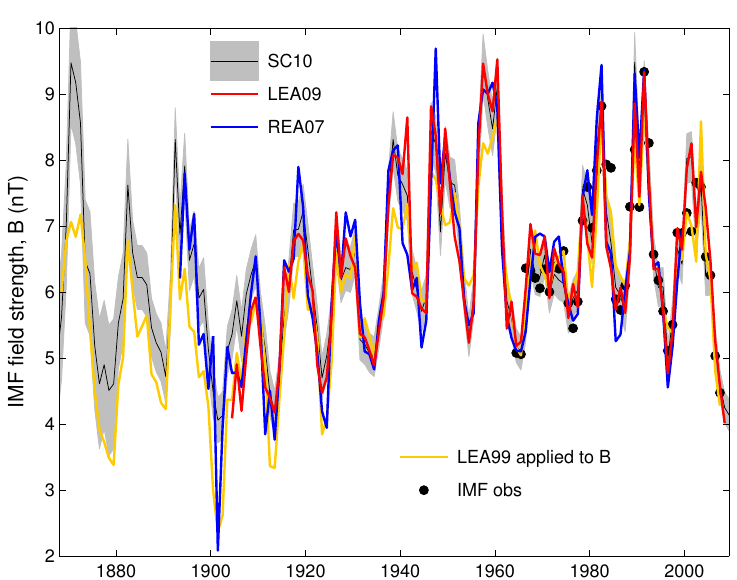
Figure 26: Reconstructions of annual means of the near-Earth IMF field strength 𝐵 from geomagnetic activity data: LEA99 (orange) uses the method of Lockwood et al. (1999a) applied to 𝑎𝑎 𝐶 ; LEA09 (red) is by Lockwood et al. (2009d) and uses 𝑎𝑎 𝐶 and 𝑚 ; REA07 (blue) is by Rouillard et al. (2007) and also uses 𝑎𝑎 𝐶 and 𝑚 ; SC10 (thin black line with uncertainty shown by the surrounding grey area) is by Svalgaard and Cliver (2010) and uses 𝐼𝐷𝑉 . Solid circles show annual means of IMF observations from the OMNI2 database. Note that Lockwood et al. (1999a) did not reconstruct 𝐵 and the LEA99 variation shown was generated by Lockwood and Owens (2011) who adapted the Lockwood et al. (1999a) procedure to predict 𝐵 . Image reproduced by permission from Lockwood and Owens (2011), copyright by